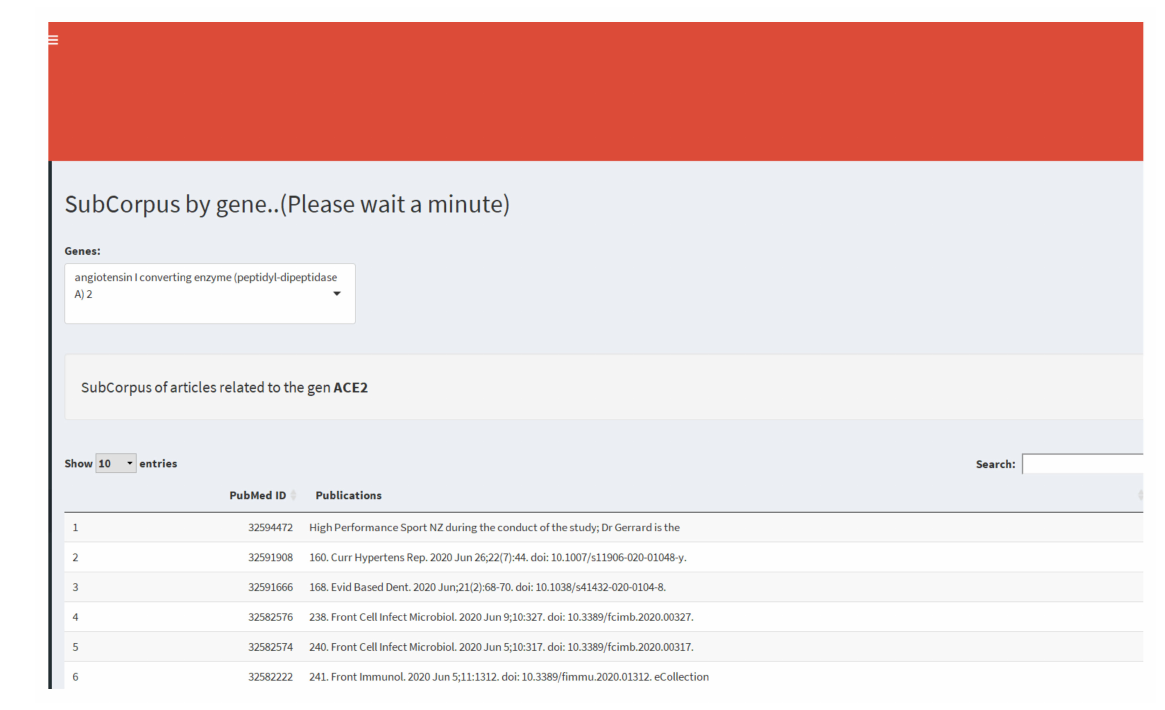
Figure 7. Filters by gene or keywords.